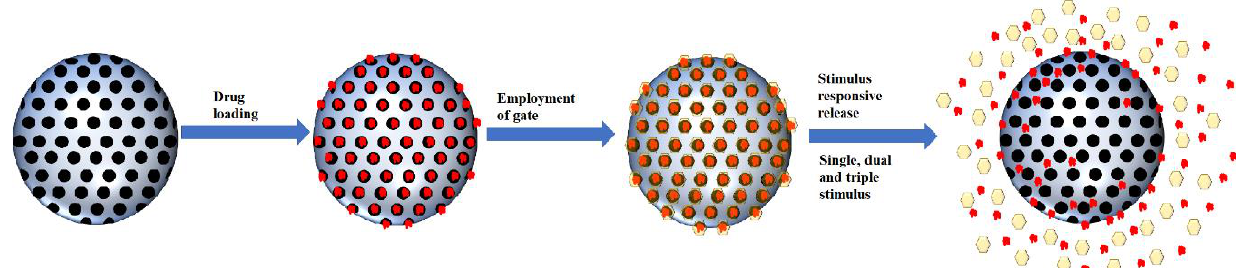
Figure 4. Schematic illustration of smart MSNs with the stimulus-responsive system.